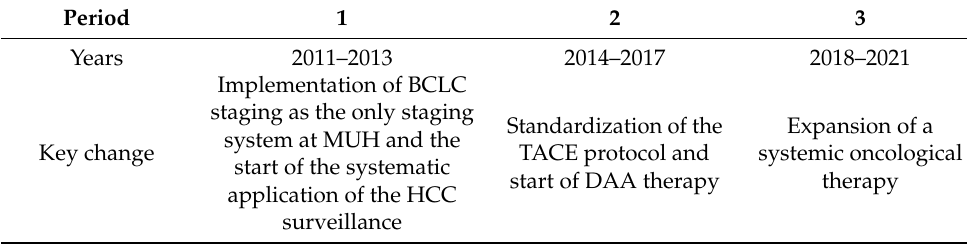
Table 1. Division of the cohort according to the key changes in HCC therapy.